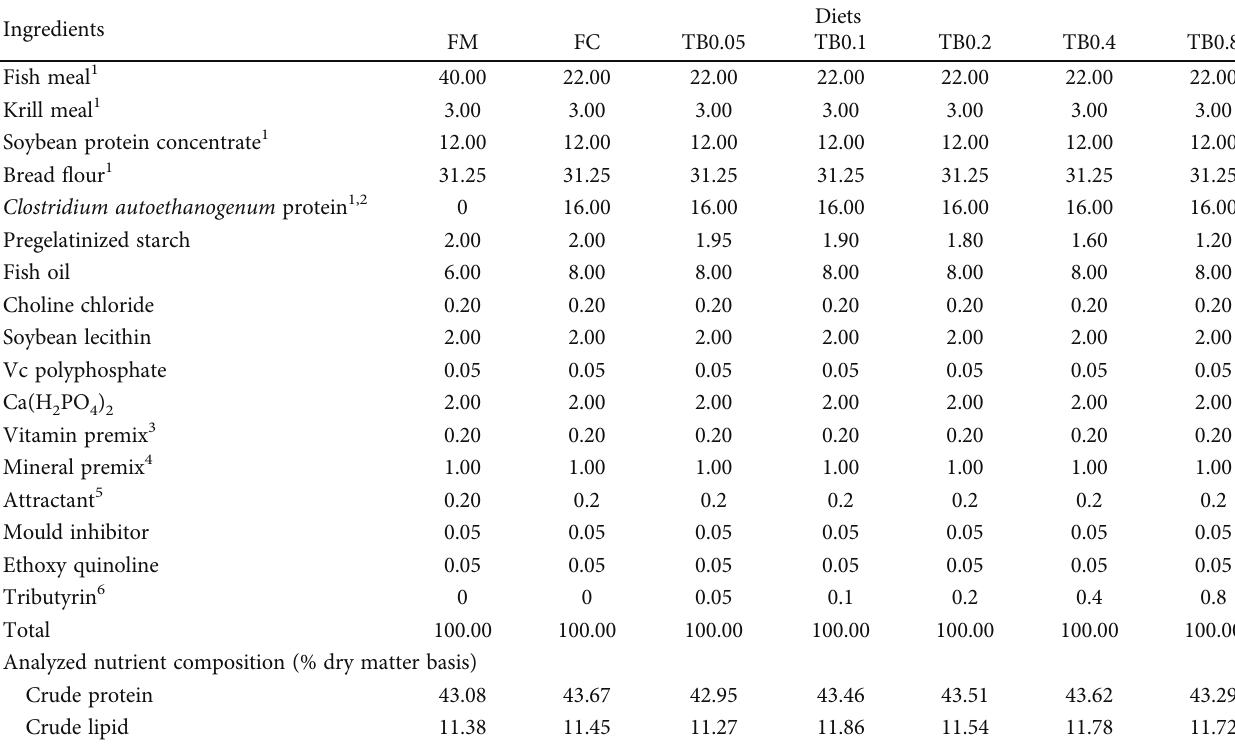
Table 3: Formulation and proximate composition of the experiment diets (% dry weight).